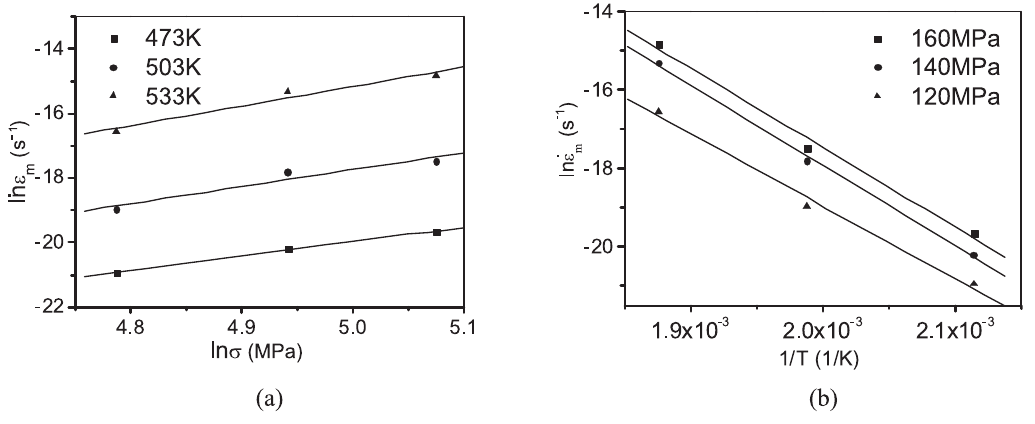
Fig. 2: Determination of n from (a) ε  ln m vs. σ ln and Q from (b) ε  ln m vs. 1/ T plots.